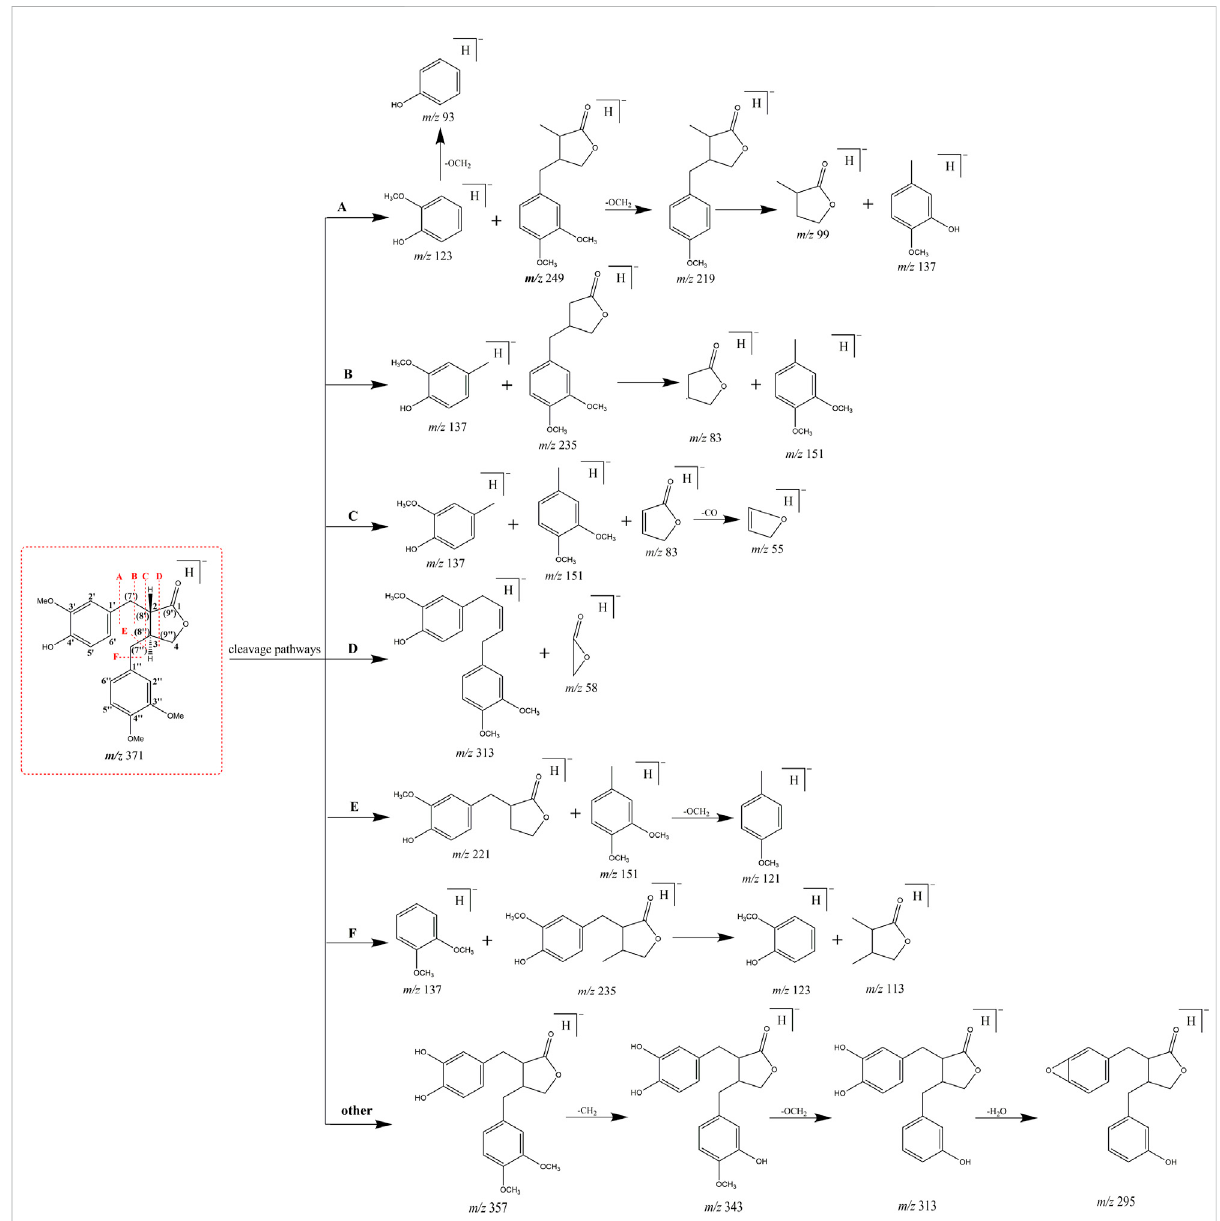
FIGURE 2 Typical cleavage pathways for